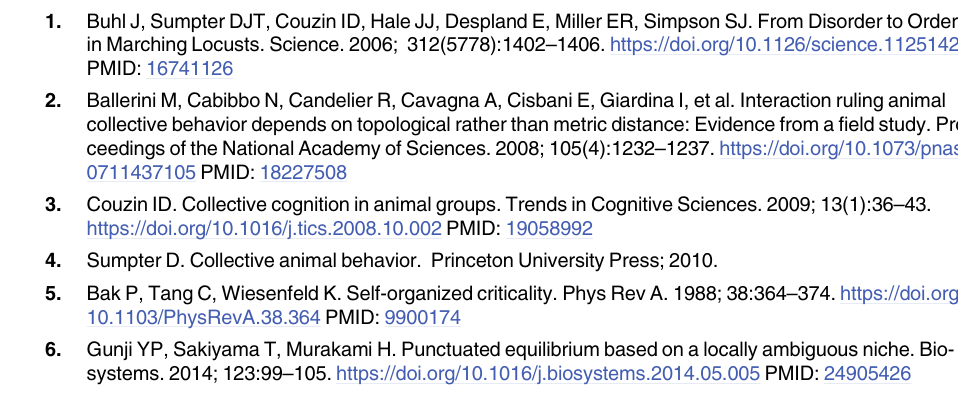
S1 Table. Statistical test results for other parameter